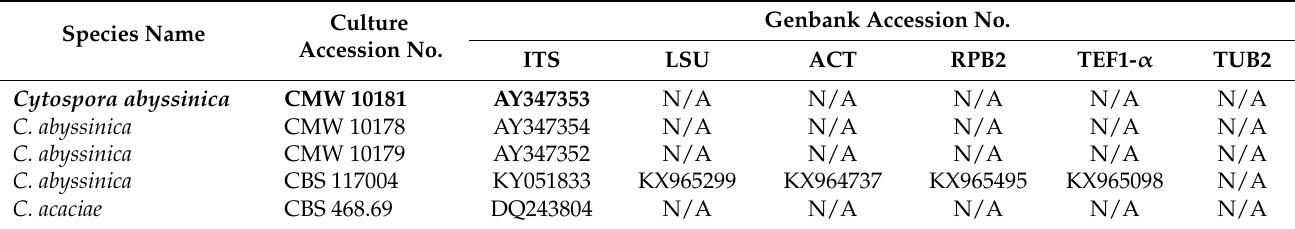
Table 2. Taxa used in the phylogenetic analyses and their corresponding GenBank accession numbers. The newly generated sequences are indicated in red bold. The ex-type strains are bold. N/A = unavailable sequence